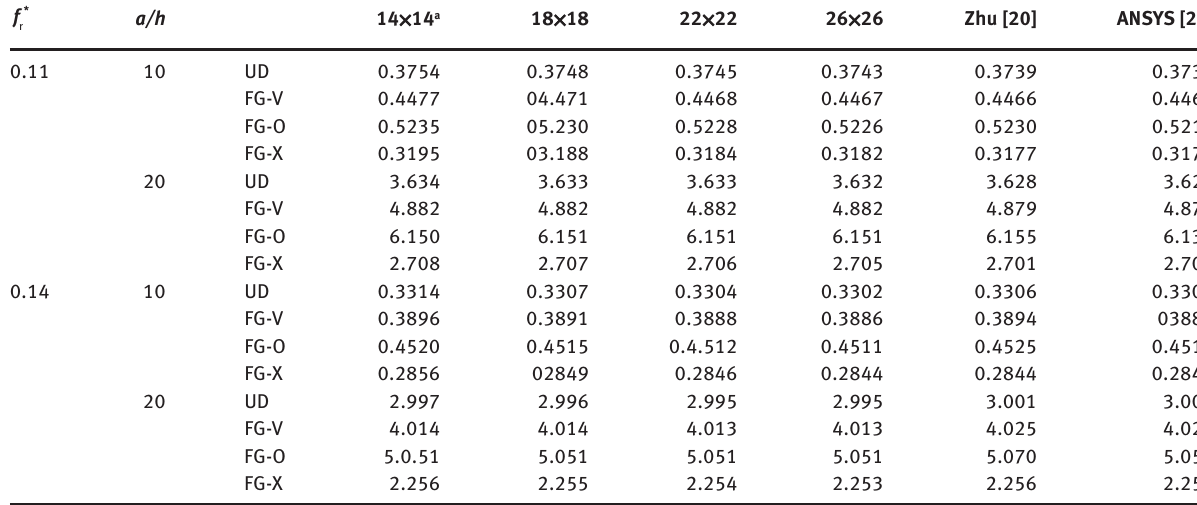
ˆ[ 100 (- / )] w = × w h for a simply supported square CNTRC plate 0